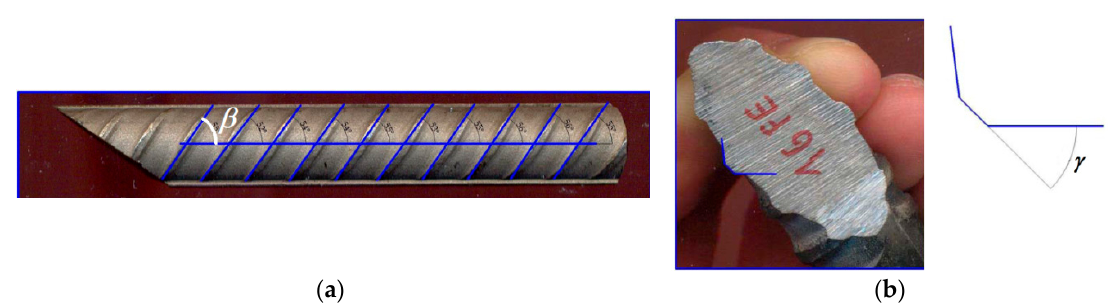
Figure 5. Inclination angles of the ribs: ( a ) angle β ; ( b ) angle γ .